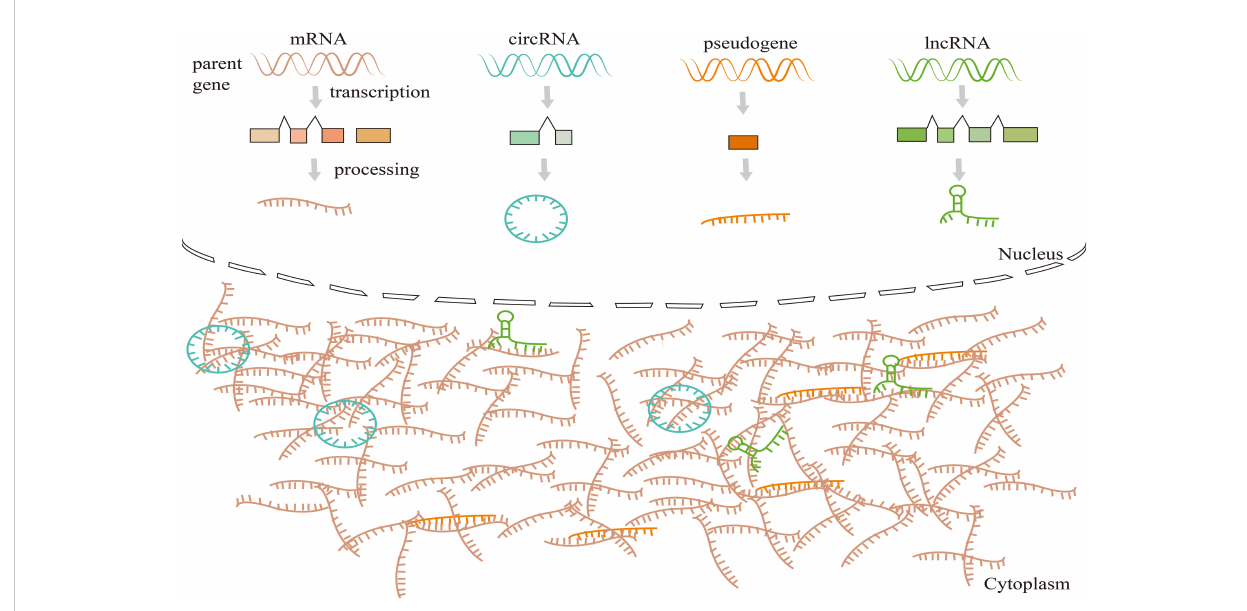
FIGURE 4 Competing endogenous RNAs (CeRNAs) networks and mechanisms. CeRNAs link the function of protein-coding mRNAs with miRNAs, lncRNAs, circRNAs, and pseudogenic RNAs. CeRNAs target binding (sponge) MREs (pseudogene transcripts, lncRNA, miRNAs, and circRNA) to revive the inhibition of downstream target genes, and this regulatory mode constitutes the ceRNA